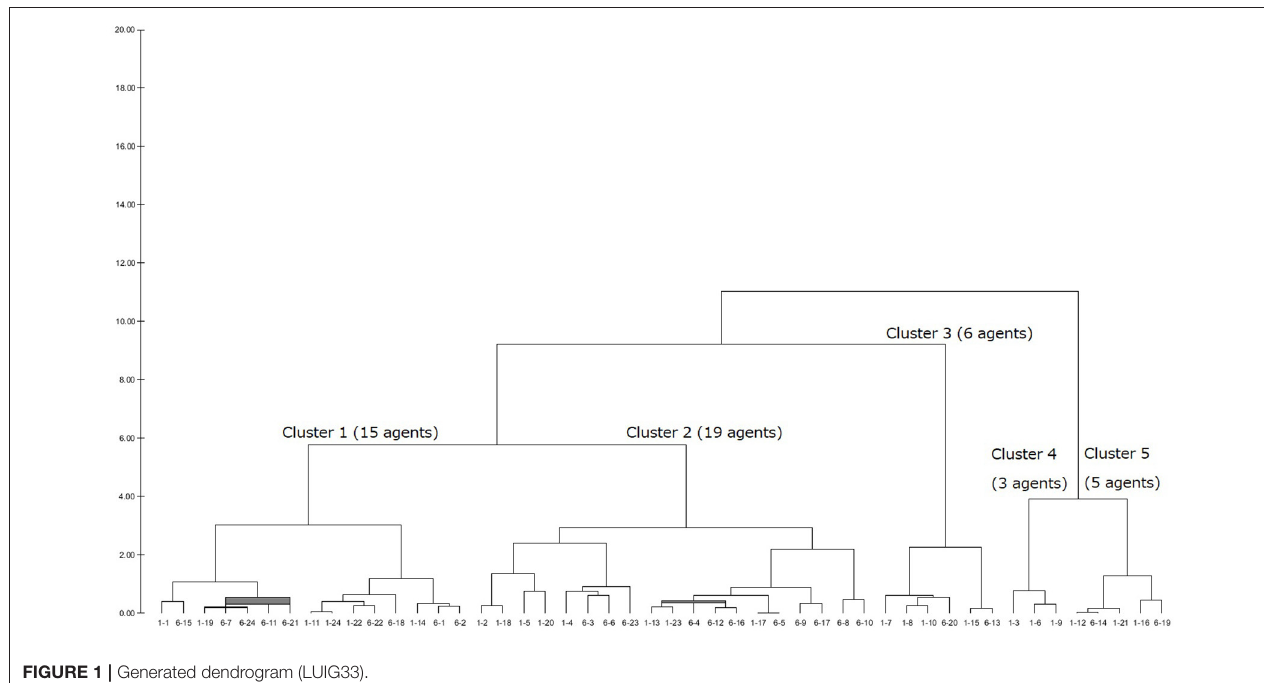
FIGURE 1 | Generated dendrogram (LUIG33).